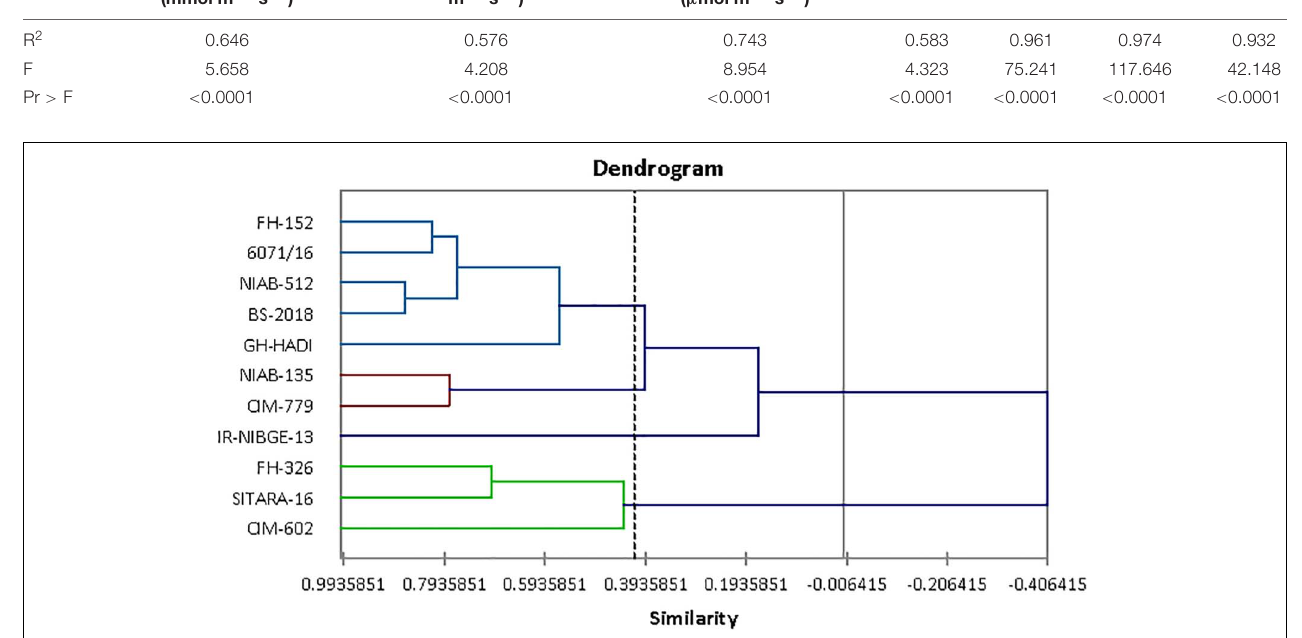
FIGURE 8 | Tree diagram based on morphophysiological traits for different cotton genotypes under control and salt stress conditions.